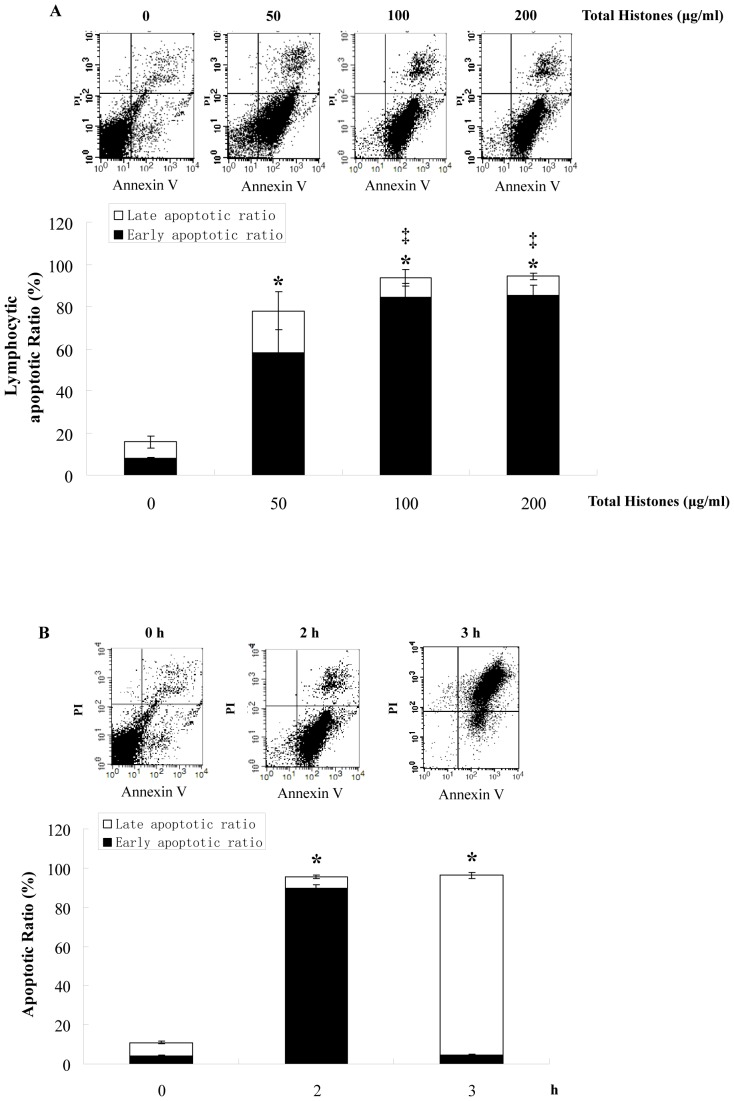
Histones induced human lymphocyte apoptosis dose-dependently and time-dependently.Human lymphocytes were cultured with histones of various concentrations (0, 50, 100, 200 µg/ml) or 100 µg/ml histones for various time durations (0, 2, 3 h). Lymphocyes were harvested and apoptotic ratio was detected by flow-cytometry. A. Dose-dependent manner. Values are presented as means ± SD (n = 3). *P<0.05, as compared with 0 µg/ml. ‡P<0.05, as compared with 50 µg/ml. B. Time-dependent manner. Values are presented as means ± SD (n = 3). *P<0.05, as compared with 0 µg/ml group.